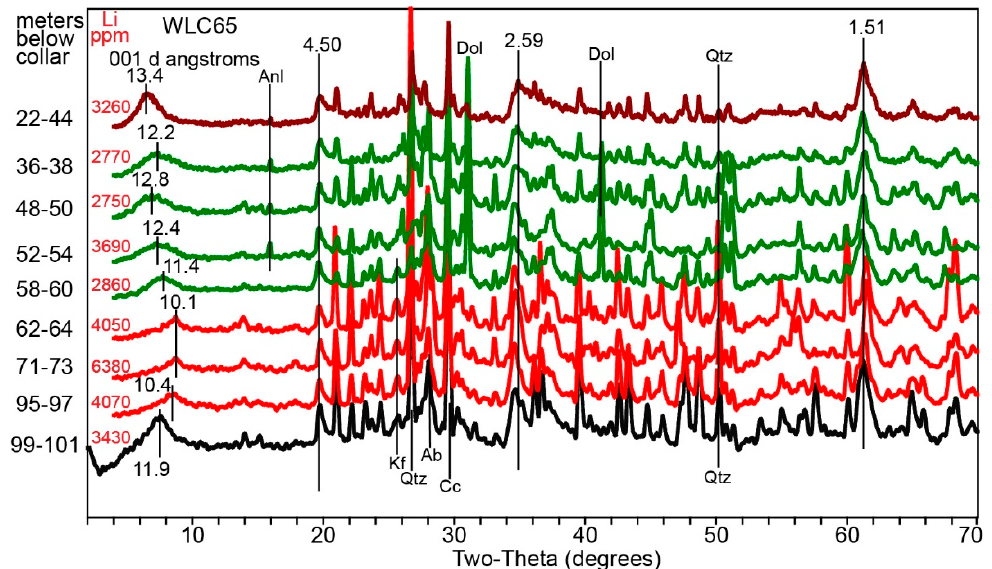
Figure 9. Series of XRD scans for bulk interval samples between 52 and 101 m in hole WLC65 with peaks showing Li contents, 001 d spacing, other major clay peaks (4.50, 2.59, and 1.51 angstroms), and peaks for analcime (Anl), quartz (Qtz), calcite (Cc), K-feldspar (Kf), and dolomite (Dol). Scans are color coded with blue = upper smectite zone, green = upper transitional clay zone, red = illite zone, and brown = lower transitional clay zone. All samples dried. Tops and bottoms of the intervals are rounded to nearest meter.